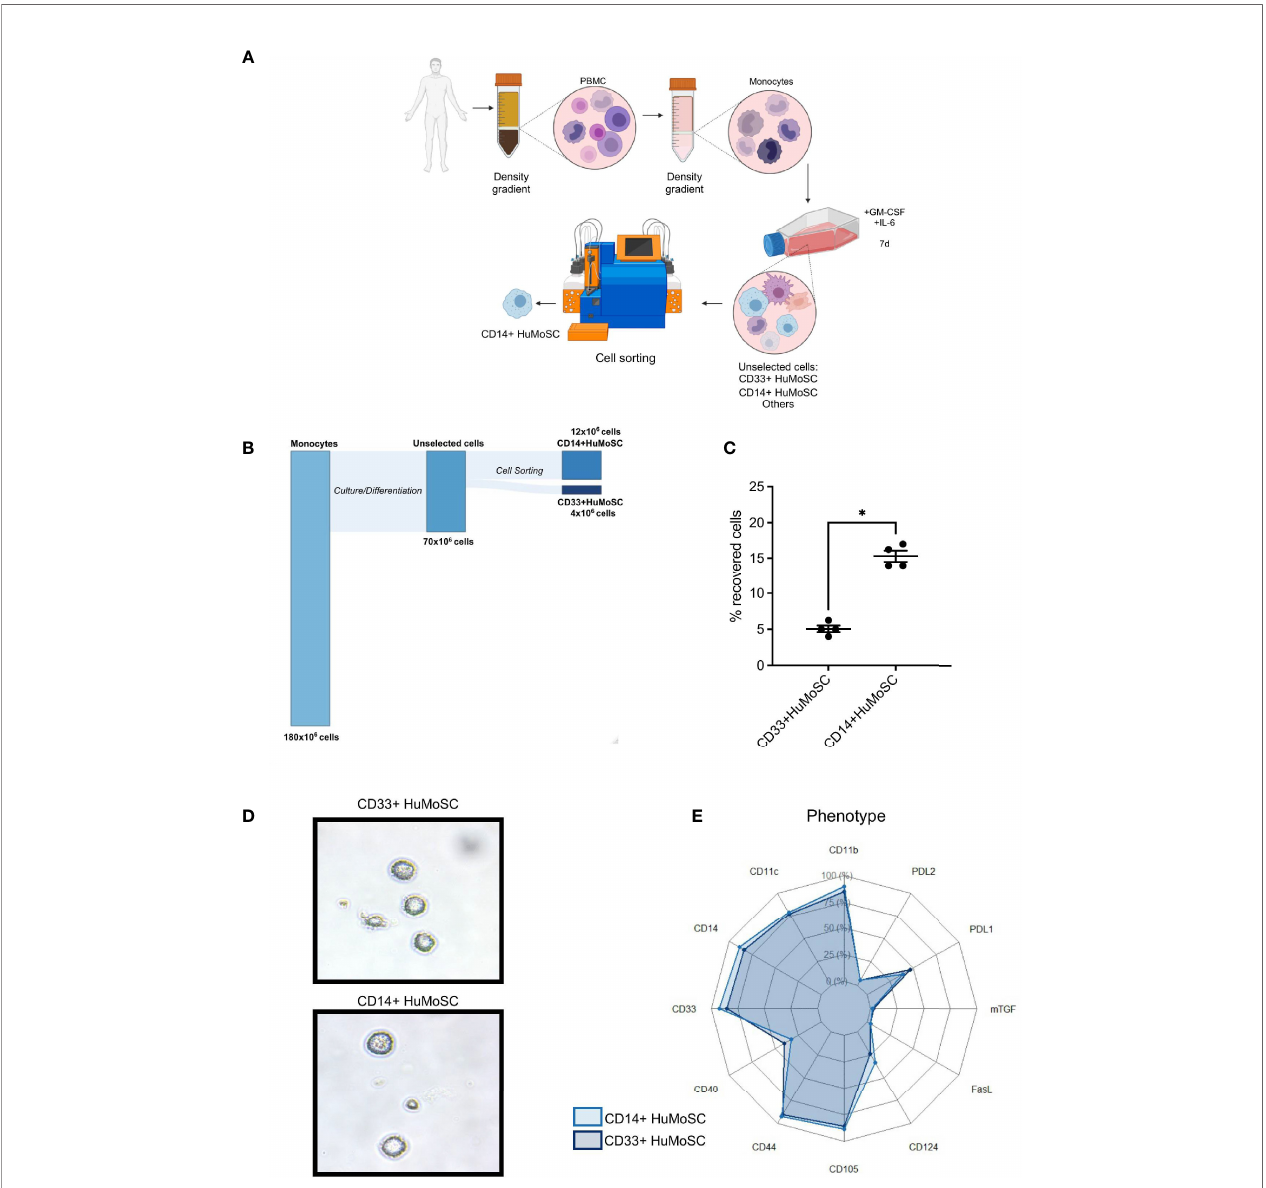
FIGURE 1 | Protocol for CD14+HuMoSC generation. (A) Schematic work fl ow of both CD33+HuMoSC and CD14+HuMoSC generation. (B) Alluvial plot illustrating the proportion of harvested cells at each step of the protocol. (C) Following HuMoSC generation, the percentage of recovered cells was evaluated after selection for both CD33+HuMoSC and CD14+HuMoSC fractions. Results of 4 independent experiments are shown. (D) Representative morphology of both CD14+HuMoSC and CD33+HuMoSC characterized by optical microscopy (magni fi cation x500). (E) Phenotypes of CD14+HuMoSC and CD33+HuMoSC were determined by fl ow cytometry. Results of 6 independent experiments are shown. Data are shown as mean ± SEM of representative experiments. Two-tailed Mann Whitney test: *p <